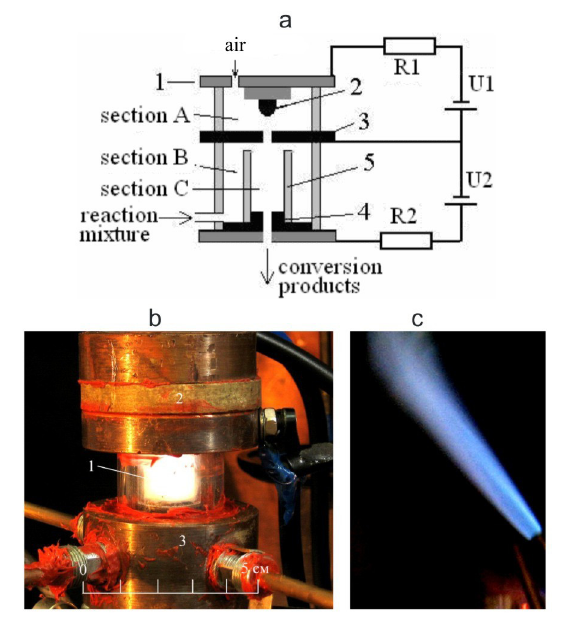
Figure 1: Schematic of plasma-chemical reactor (a) and photos of discharge during ethanol conversion (b) and flame at the reactor output